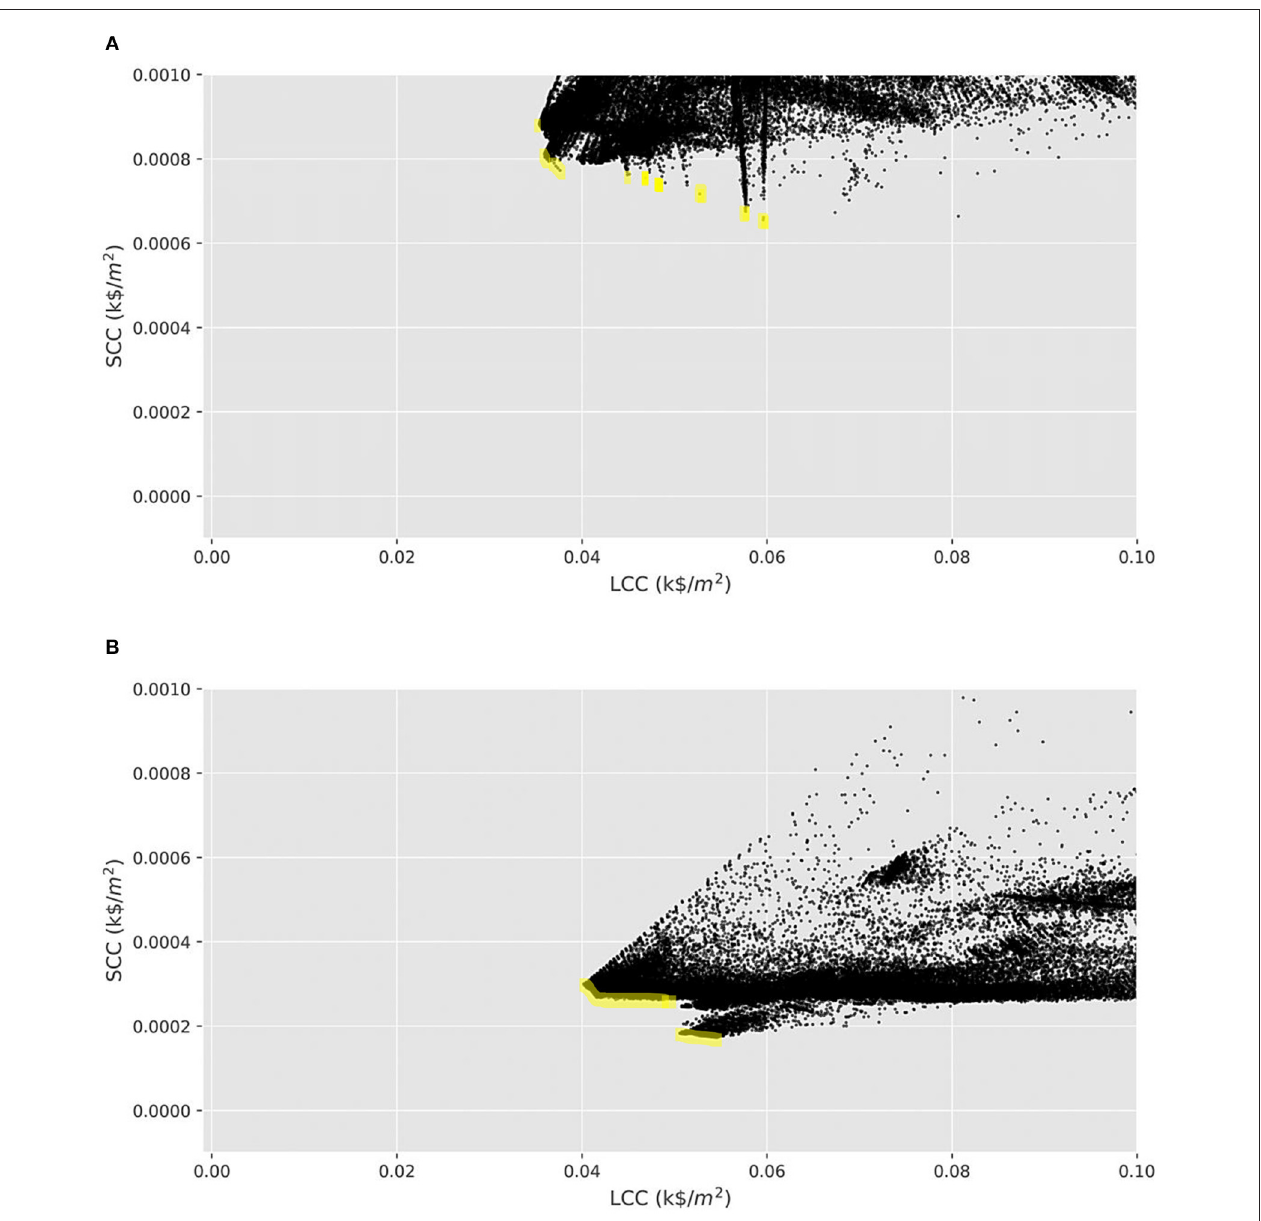
FIGURE 5 | The approximate Pareto fronts of the life-cycle social cost of carbon vs. life-cycle cost of equipment for (A) scenario 1 and (B) scenario